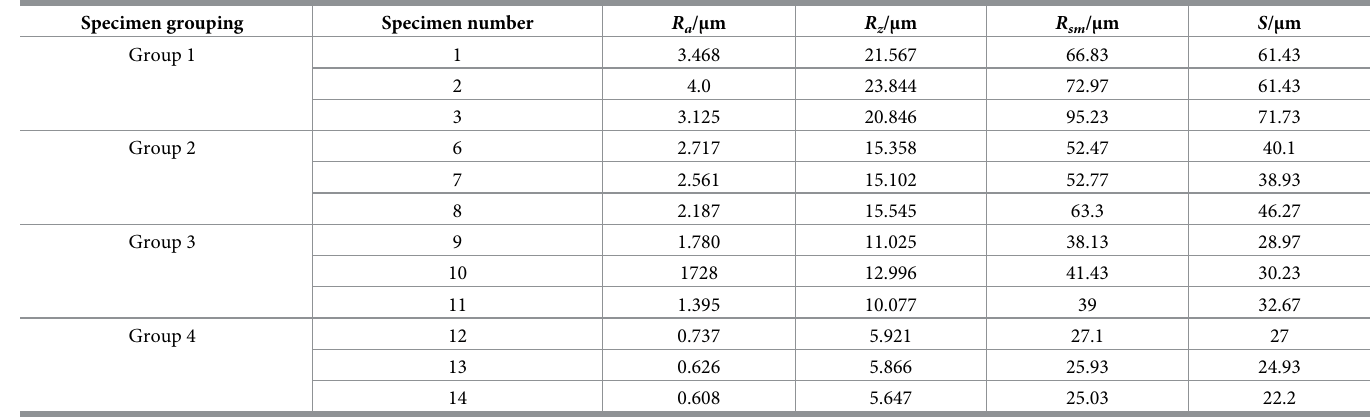
Table 3. Roughness values of each